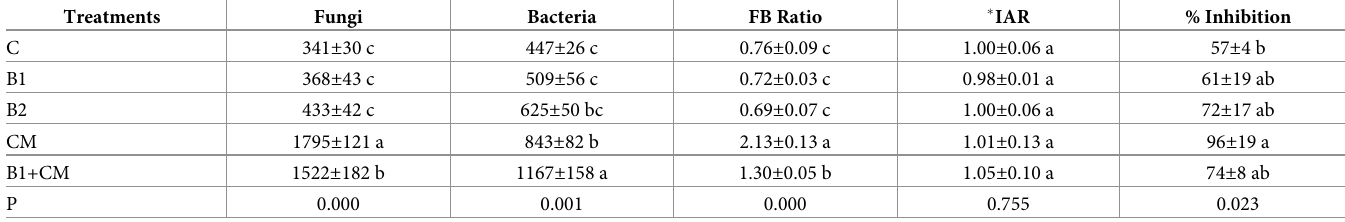
Table 4. The substrate induced respiration (selective inhibition).